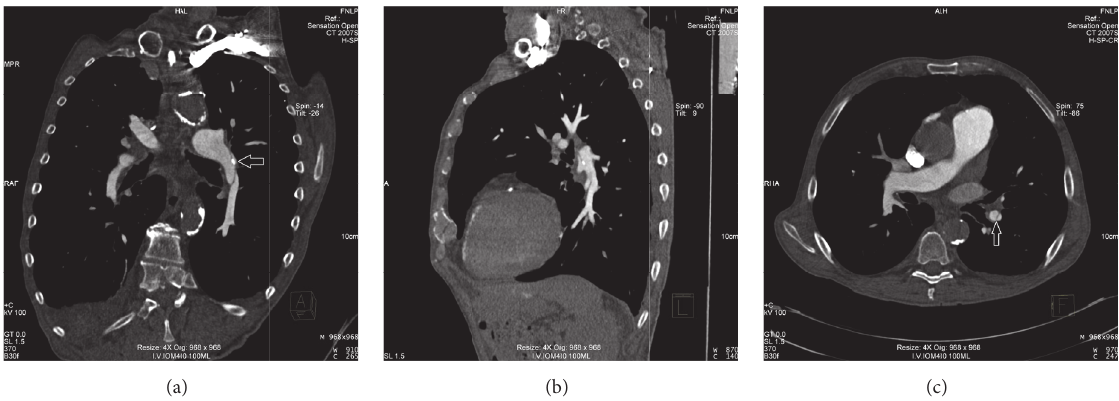
Figure 1: Coronal and sagittal curved MPR section (a, b) of a contrast-enhanced CT pulmonary angiogram showing long thin dissection flap in the lower lobe branch of the left pulmonary artery with partial involvement of the left pulmonary artery with a small intimal flap calcification (white arrow) and axial section with partial involvement of the lower segmental branch (white arrow)